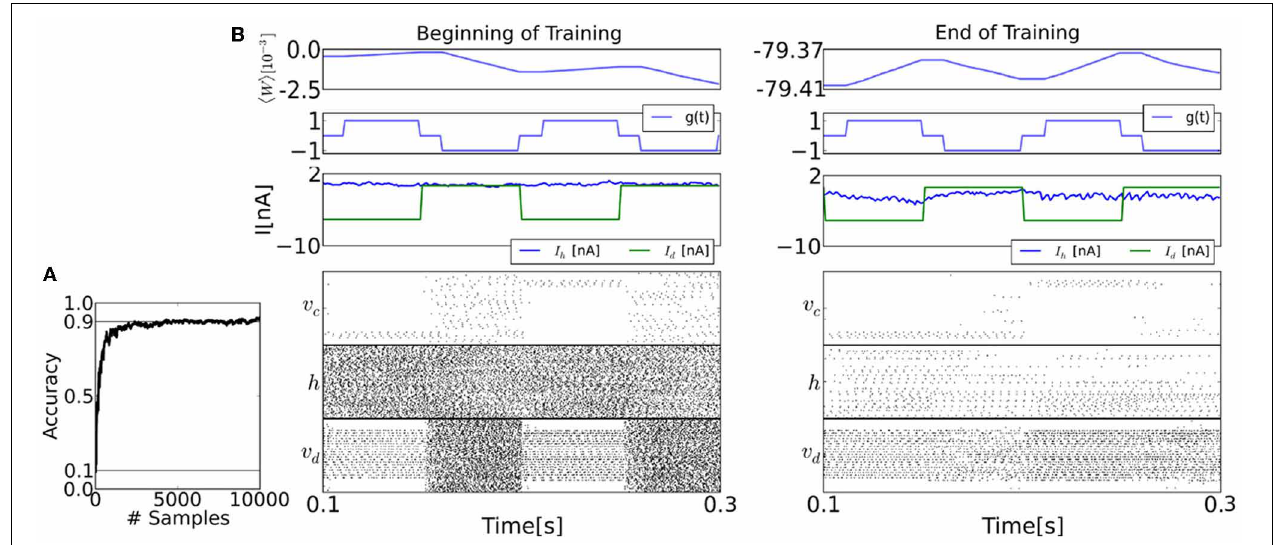
bias, and I d is the data. The timing of the clamping ( I d ) and g differ due to an interval τ br where no weight update is undertaken to avoid the transients (see section 2). Before learning and during the reconstruction phase, the activity of the visible layer is random. But as learning progresses, the activity in the visible layer reflects the presented data in the reconstruction phase. This is very well visible in the layer class label neurons v c , whose activity persists after the sensory stimulus is removed. Although the firing rates of the hidden layer neurons before training is high (average 113Hz), this is only a reflection of the initial conditions for the recurrent couplings W . In fact, at the end of the training, the firing rates in both layers becomes much sparser (average 9 .